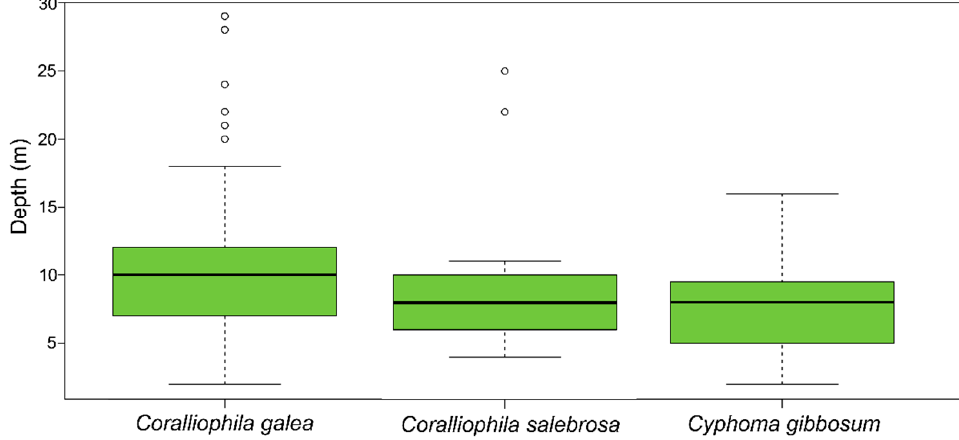
Figure 6. Box plot comparing the depth distributions for the different snail species. Interspecific variation is significant (ANOVA: F = 5.27; p < 0.05) but differences between any two species are not.